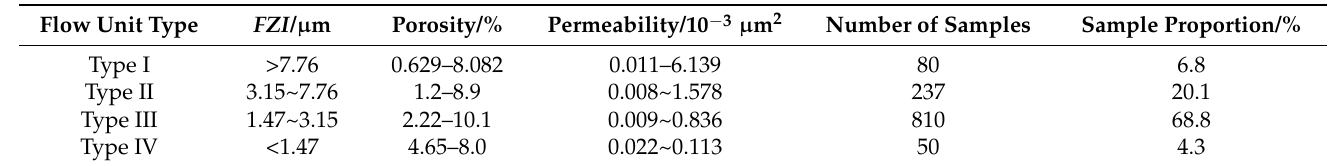
Figure 7. The cumulative frequency distribution of FZI in the granitic formation in No. 2 Gas Field. Table 2. Classification criteria for different flow units in low-permeability tight reservoirs of granitic formation in No. 2 Gas Field.